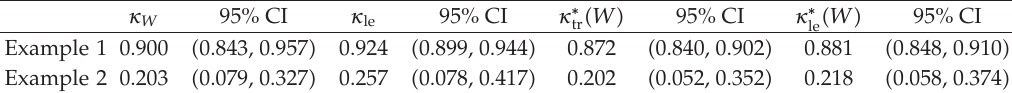
Table 5: Results for the two